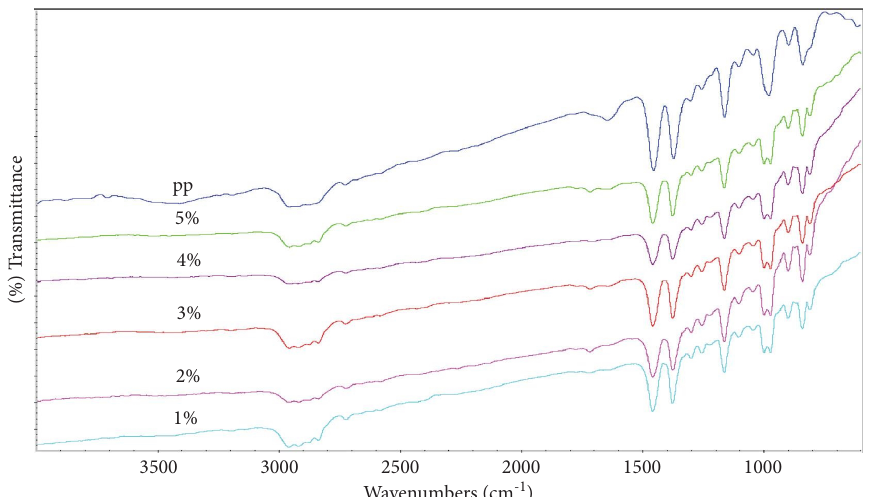
Figure 6: FTIR spectra of pure PP and #16